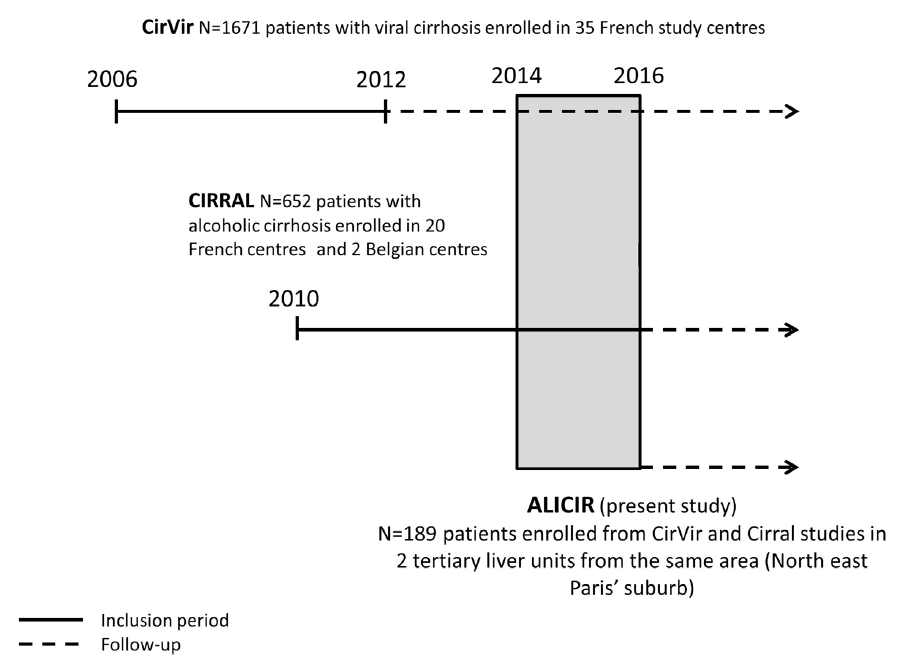
Figure 1. Description of patient